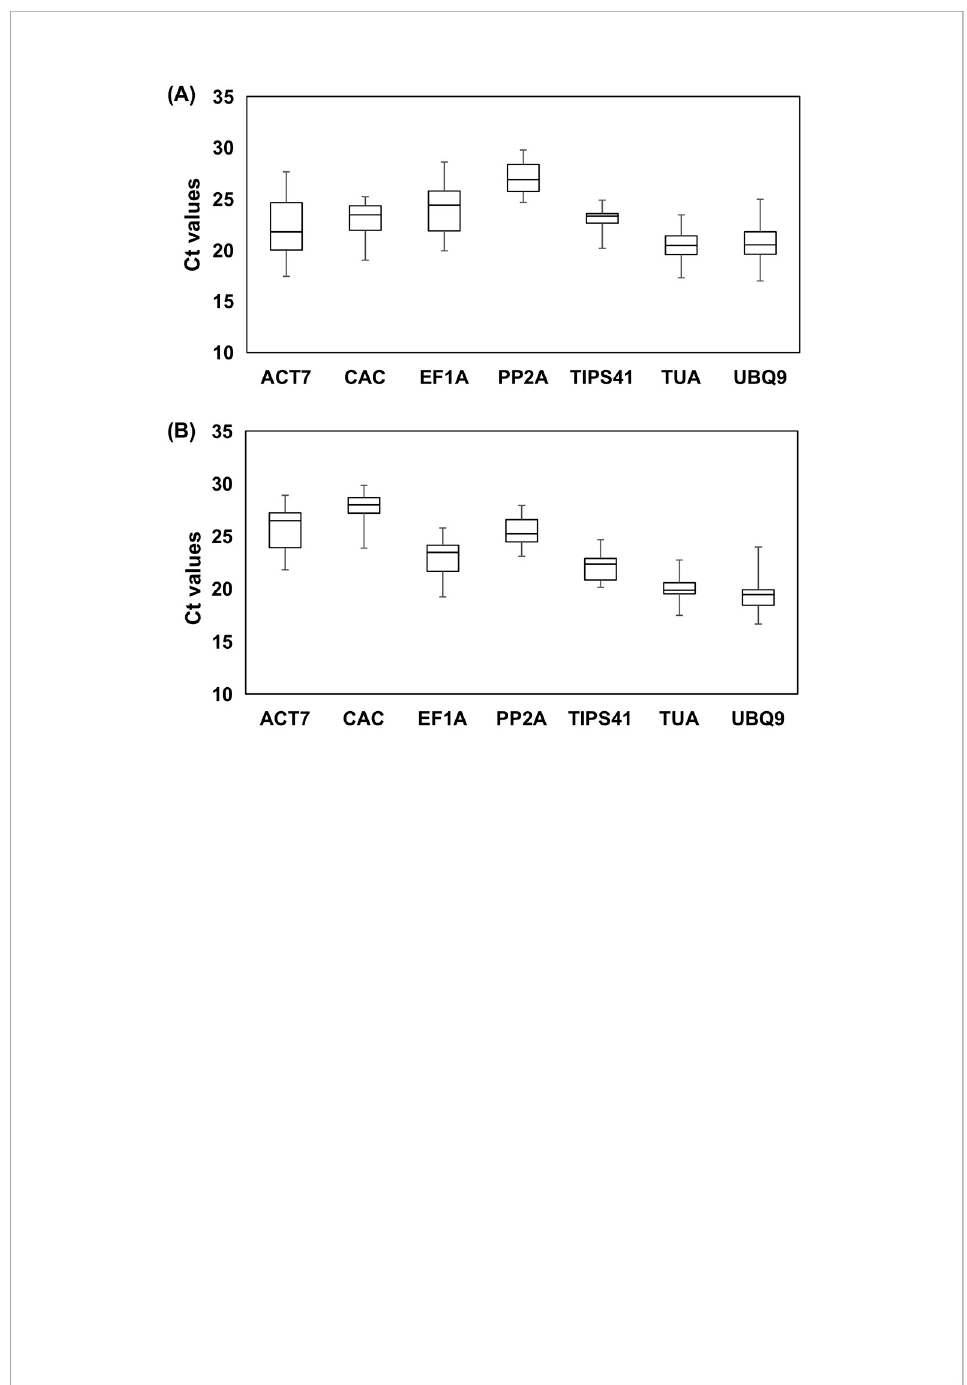
Fig 2. Expression levels of seven candidate RGs across all the experimental sets. (A) B . juncea (B) C . sativa . Solid line in the middle of the boxes represents median, and the boxes represents 25 th and 75 th percentile. Whiskers indicate the maximum and minimum